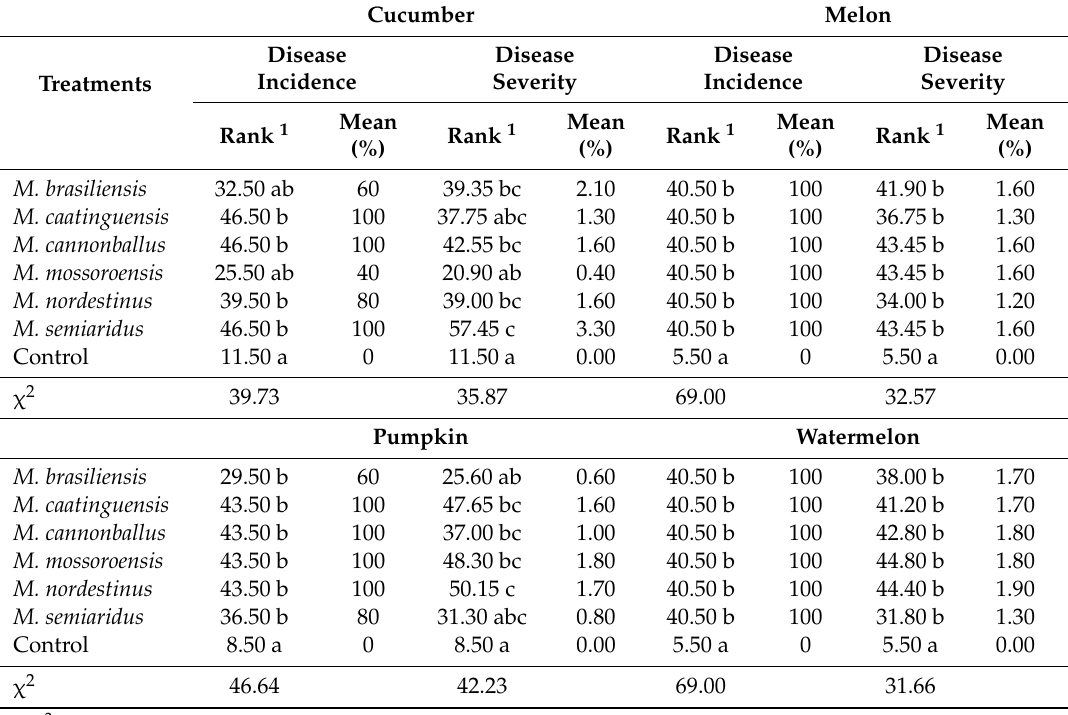
Table 2. Incidence and severity of the disease in cucumber, melon, pumpkin, and watermelon seedlings by Monosporascus spp.